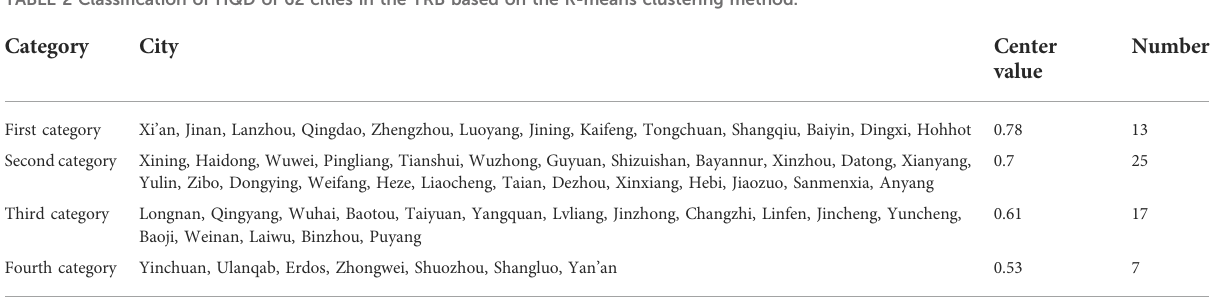
TABLE 2 Classi fi cation of HQD of 62 cities in the YRB based on the K-means clustering method. Category City Center